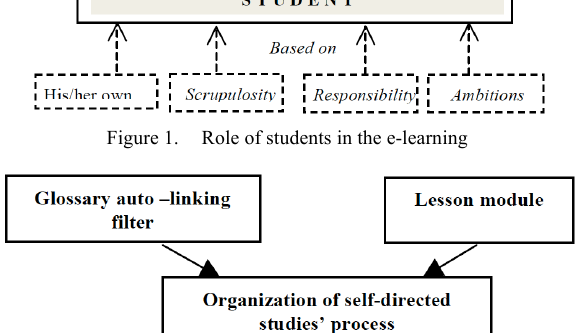
Figure 2. Moodle tools for organization of self-directed studies’ pro- cess